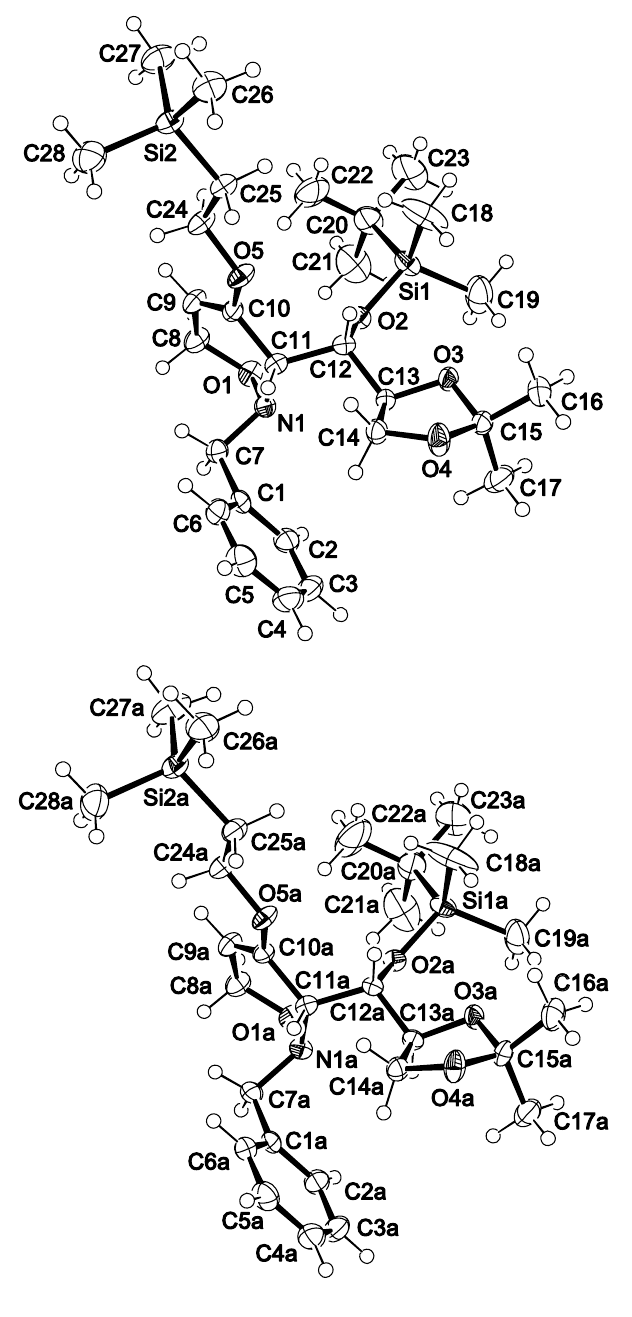
H NO Si 28 49 5 2